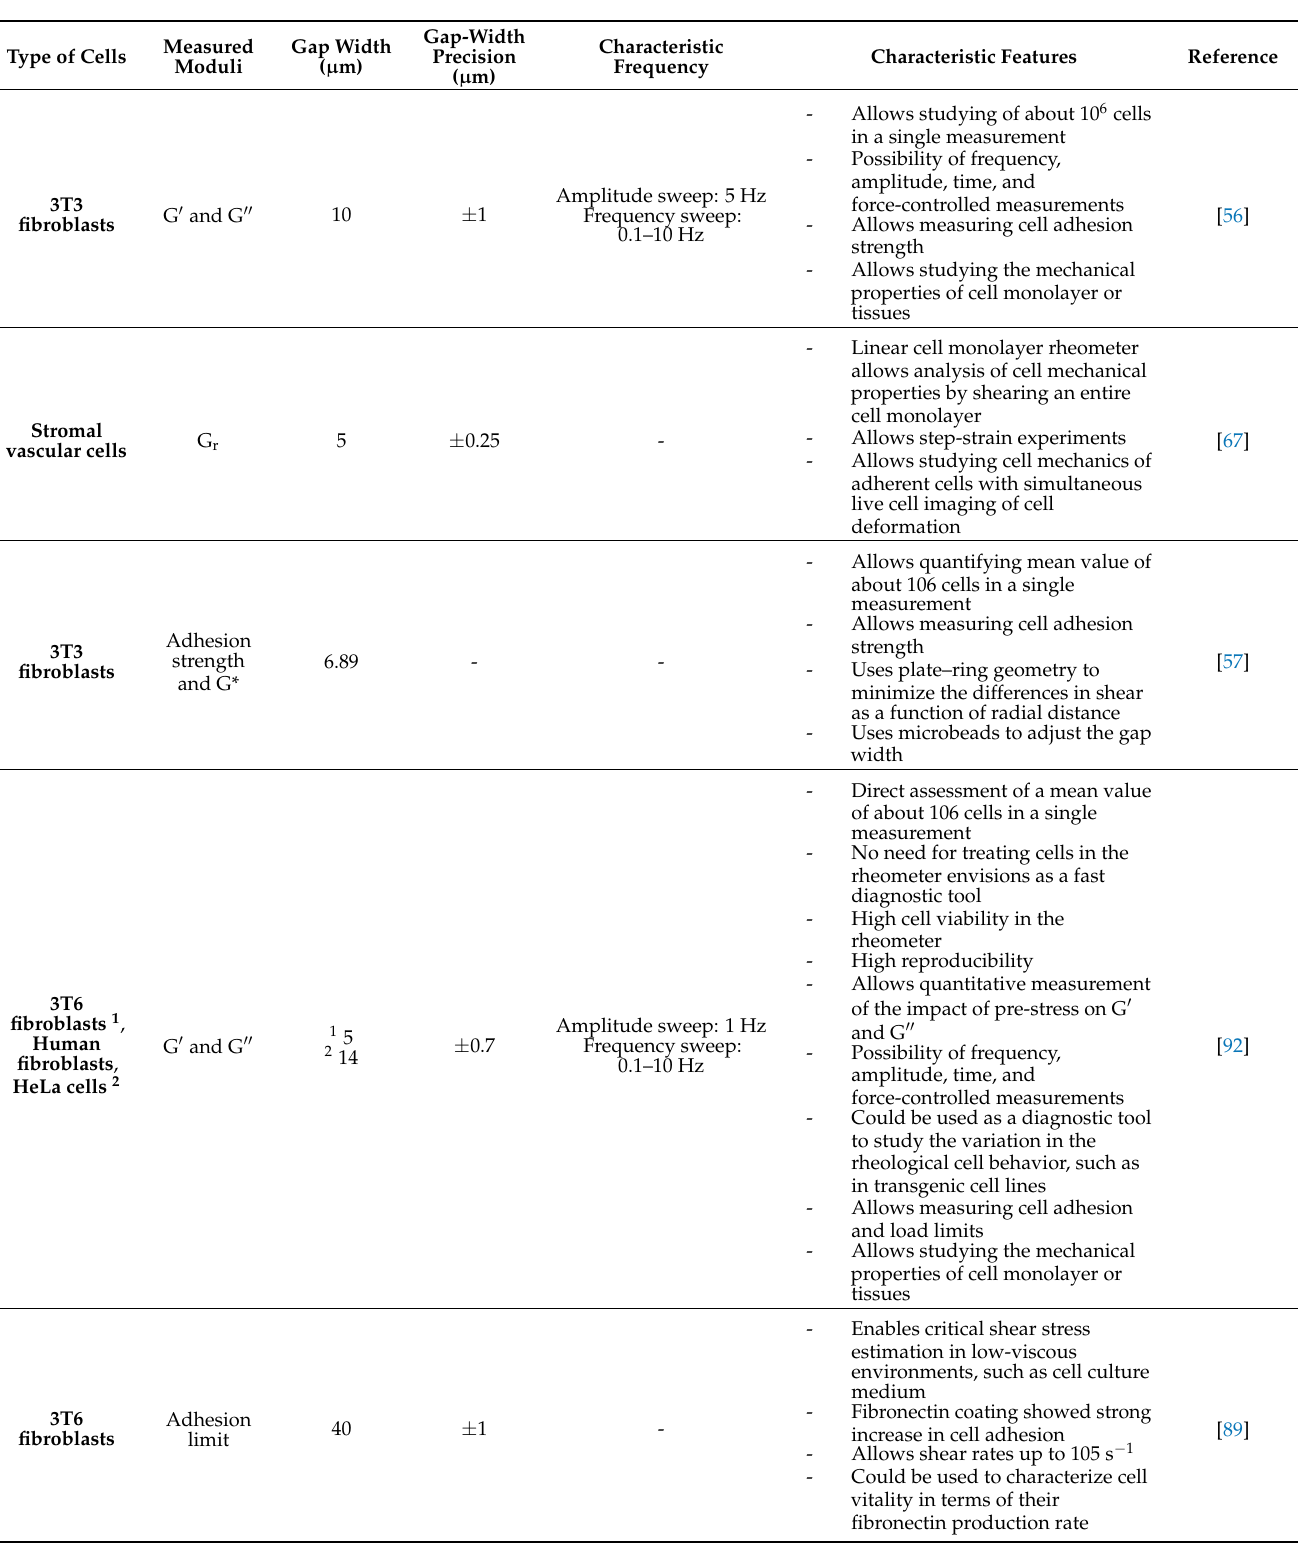
Table 2. Applications of narrow-gap rheology for cell mechanical